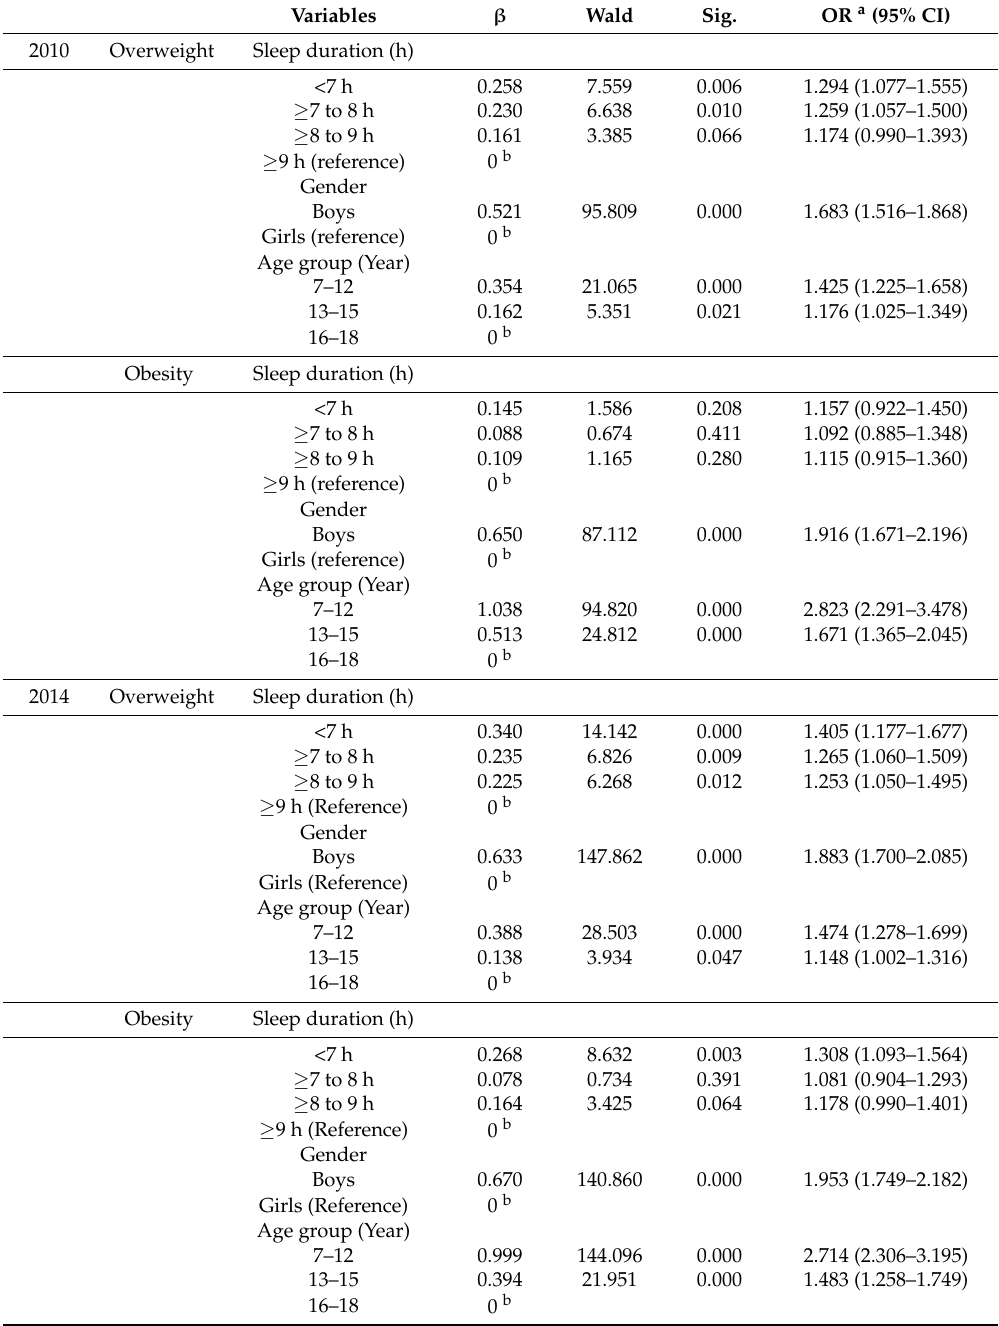
Table 6. Summary of multivariate logistic regression model predicting obesity and overweight in 2010 vs.